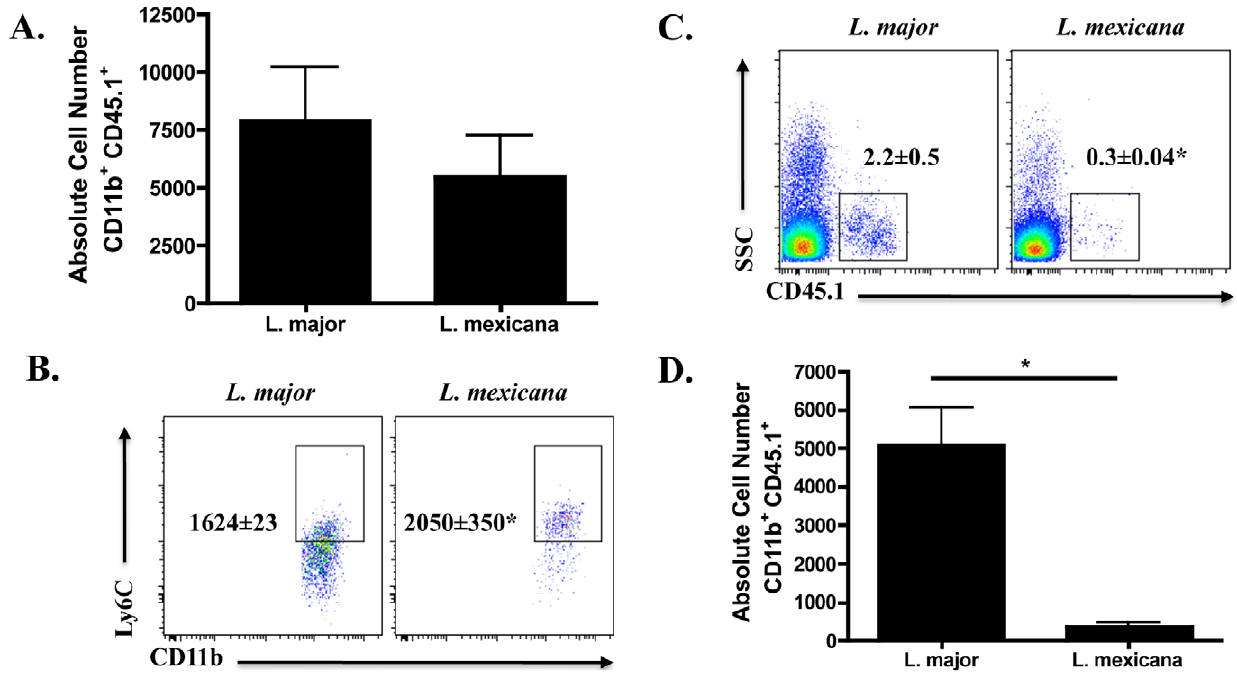
Figure 5. Fewer transferred monocytes migrate to the dLN during L.mexicana infection compared to L.major . Monocytes enriched from CD45.1 C57BL/6 mice were injected into the ear of CD45.2 C57BL/6 mice that were infected for two weeks with either L. major or L. mexicana . Eighteen hours following injection of the monocytes, ears and dLNs were harvested and processed. ( A ) Absolute number of transferred monocytes (CD11b + CD45.1 + ) in the ear. Cells are previously gated on total, live cells that are singlets. ( B ) Mean fluorescence intensity (MFI) of Ly6C on transferred cells recovered from the ears of infected mice. Percentage ( C ) or absolute number ( D ) of CD45.1 + cells in the dLN. These cells are previously gated on live, singlets that are CD11b hi cells. The results expressed are the mean percentage ( 6 SD for FACS plots) or the mean number of cells ( 6 SE for bar graphs) of 3 mice per group. The results are representative of two experiments. * significantly different (p , 0.05) compared to L. major infected